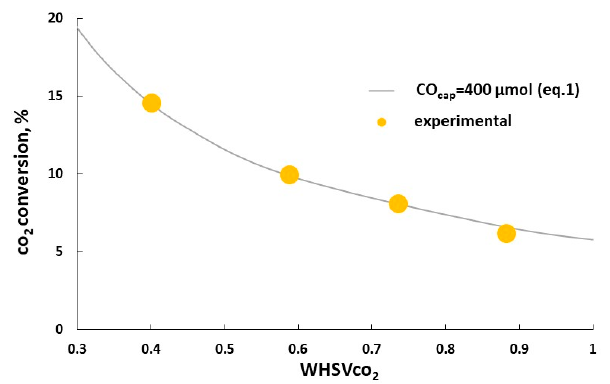
Figure 14. Effect of WHSV CO2 on CO 2 conversion at inlet CO 2 concentration of 5 vol% with Figure 14. E ff ect of WHSV CO2 on CO 2 conversion at inlet CO 2 concentration of 5 vol% with 6%K/BaFeHAl-30 catalysts obtained in isothermal conditions: T r = 550 °C; T CO2-ox = 550 °C. 6%K / BaFeHAl-30 catalysts obtained in isothermal conditions: T r = 550 ◦ C; T CO2-ox = 550 ◦